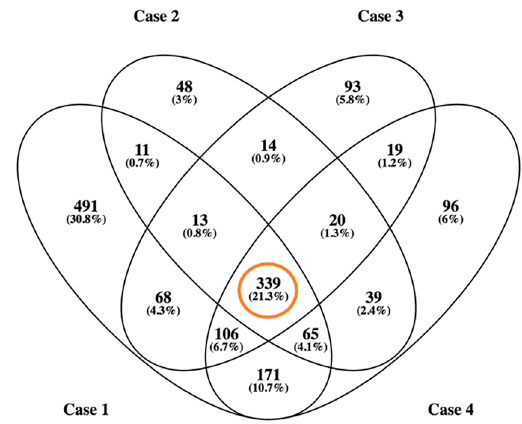
Figure 4. Venn diagram of identified proteins in thrombotic material obtained from the four subjects. In total, around 1600 protein species were identified.